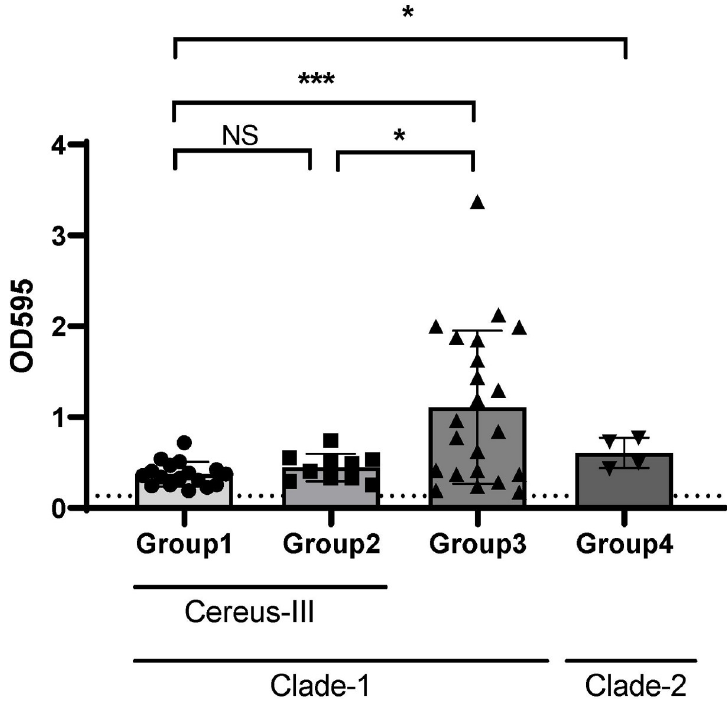
Fig 2. Difference of biofilm formation among the three groups. Biofilm formation was determined by measuring the OD595 nm after crystal violet staining. An absorbance value < 0.13 represents a biofilm-negative strain. Three independent biological experiments were performed, each with four technical replicates. The data are presented as the mean ± SD. Cut-off value was defined as two standard deviations above the mean of negative control. NS: not significant, � p < 0.05, ��� p <